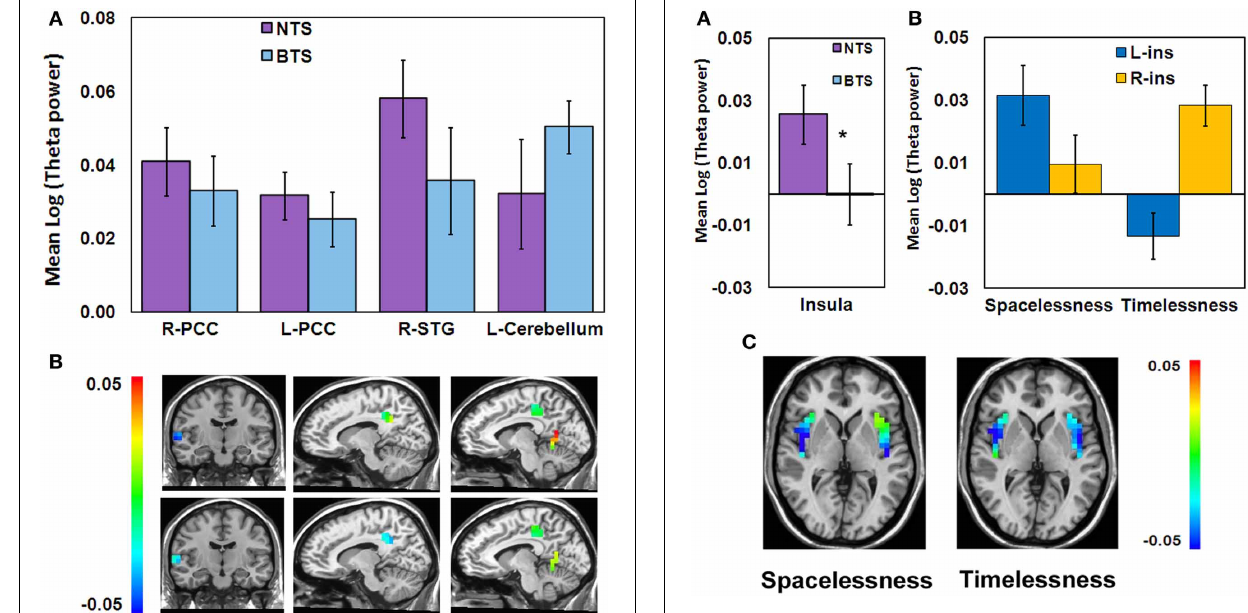
FIGURE 6 | Differences in theta activity between the BTS ( n = 5) and NTS ( n = 6) groups over 4 overlapping ROIs. (A) Group × Cluster interaction. BTS, both time and space; NTS, Not both Time and Space; (B) Spacelessness (top) and Timelessness (bottom) group theta differences within the 4 clusters, calculated as BTS minus NTS. Color scale denotes log(theta power) values. Left column—right superior temporal gyrus (STG); Middle column—right posterior cingulated cortex (PCC); Right column—left PCC and cerebellum clusters.